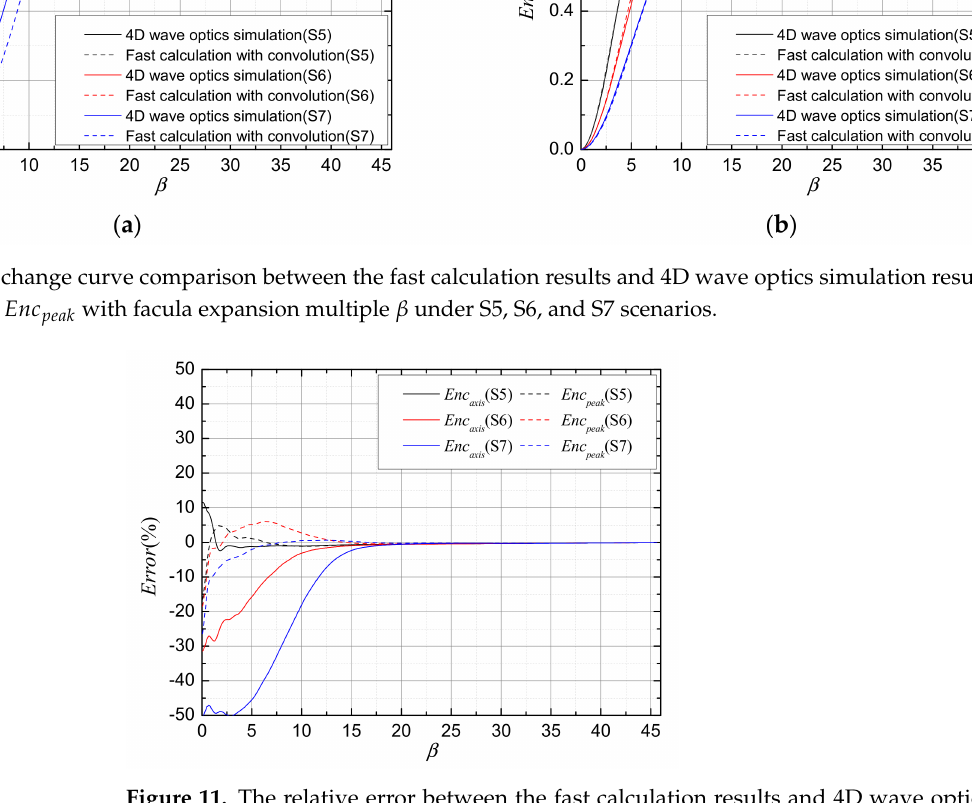
Figure 11. The relative error between the fast calculation results and 4D wave optics simulation results for Enc axis and Enc peak under S5, S6, and S7